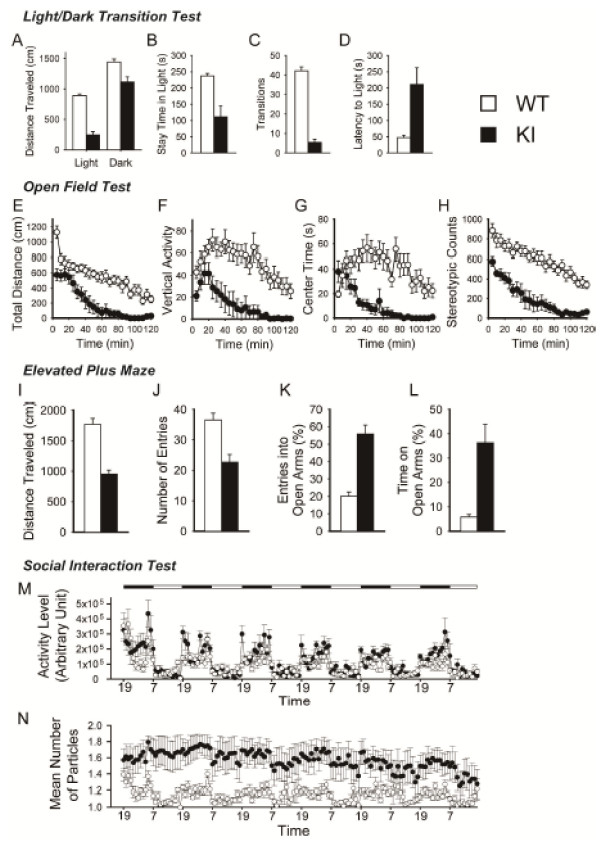
Hypoactivity and increased anxiety-related behavior in a novel environment and reduced social interactions in the home cages of 1d2d-PSD-95-EGFP KI mice. A–D, Light/dark transition test (WT controls, open bars, n = 15; KI, filled bars, n = 16): distance traveled in the light/dark compartments (A), time spent in the light compartment (B), number of light/dark transitions (C), and latency to enter the light compartment (D) were recorded. E–H, Open field test (WT controls, open circles, n = 16; KI, filled circles, n = 16): total distance traveled (E), vertical activity (F), time spent in the center of the compartment (G), and stereotypic counts (H) were recorded. I–J, Elevated plus maze test (WT controls, open bars, n = 15; KI, filled bars, n = 13): distance traveled in the arms (I), number of entries into the arms (J), number of entries into the open arms (K), and time spent in the open arms (L) were recorded. M–N, Social interaction test in the home cages (WT controls, open circles, n = 7; KI, filled circles, n = 6): KI mice were more active at night than WT mice (M) and the mean number of particles representing the mice acting separately were significantly higher all day long in the KI mice compared to the WT mice (N).